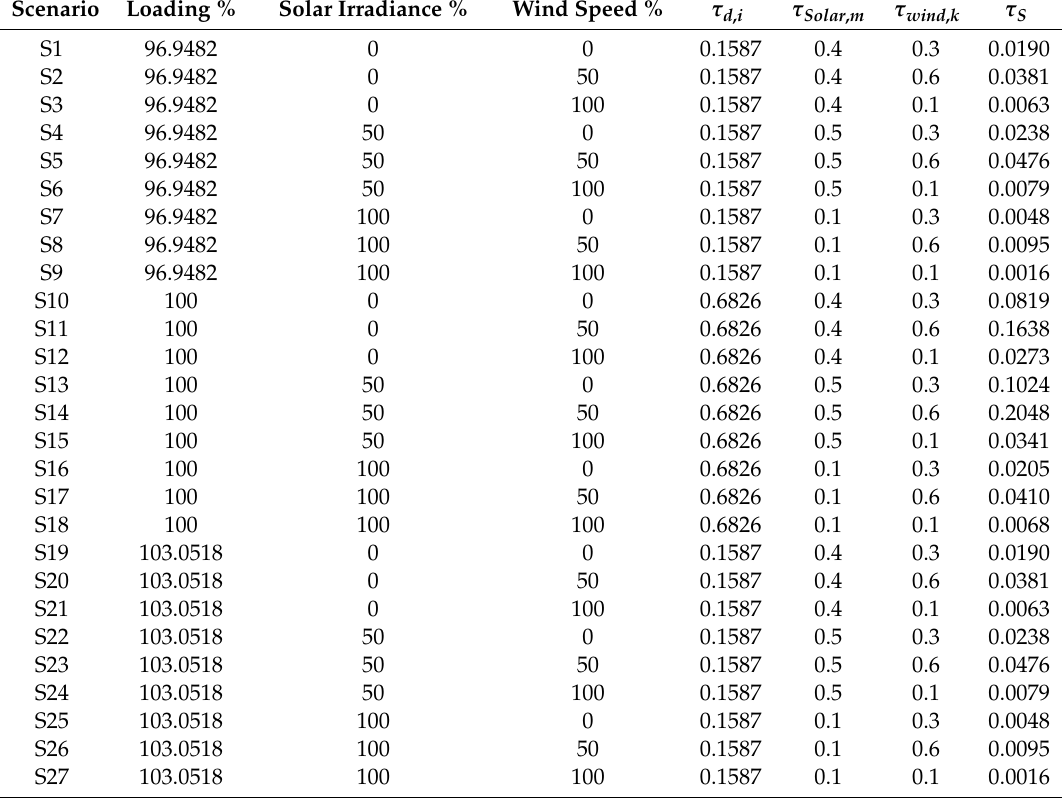
Table 5. Selected scenarios and the corresponding probabilities and